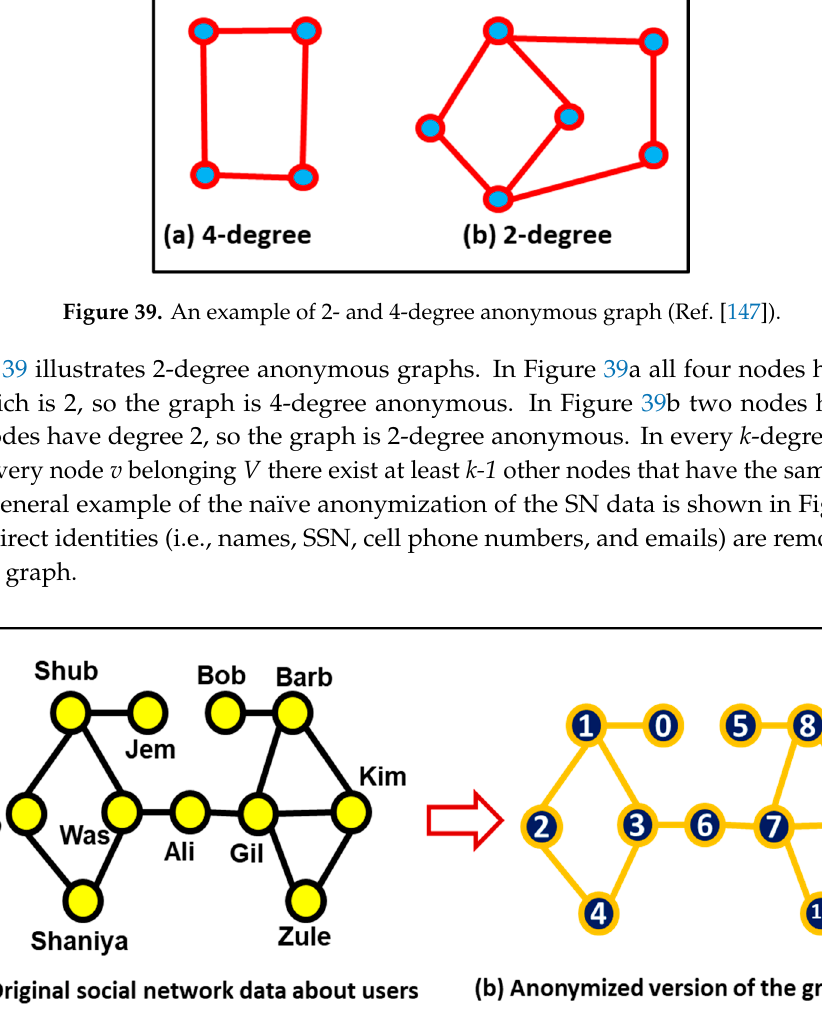
24 of 38 Figure 38. Equilibrium pattern-based four network structures used in production technologies (Ref. [138]). 3.12. Privacy-Preserving Social Network Data Publishing With Researchers/Analysts For Analysis Tremendous amounts of data are being generated/collected by organizations like hospitals, banks, e-commerce, and retail and supply chains from their users/consumers/subscribers. Just like